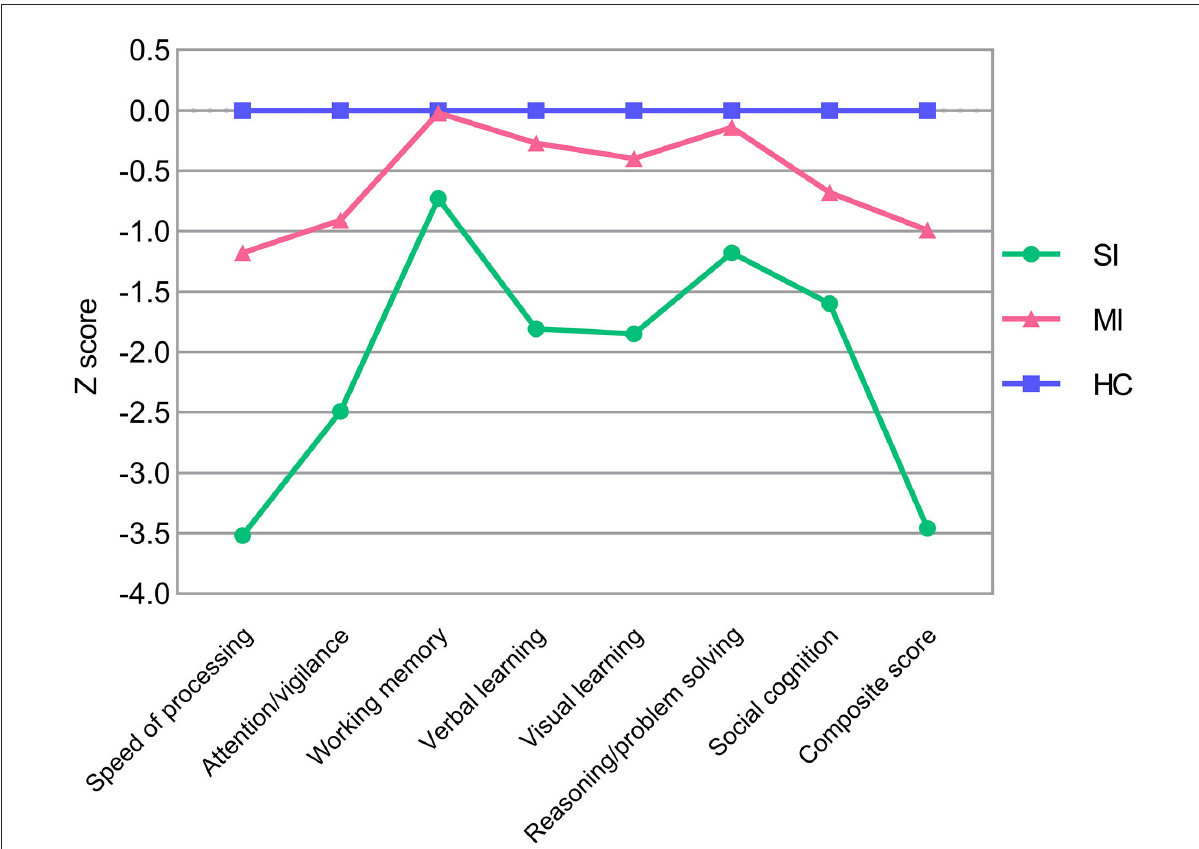
FIGURE1 MCCB cognitive scores in ECS cognitive subtypes (SI and MI) and HCs. Z scores of ECS cognitive subtypes are standardized against means and SDs of HC (mean = 0, SD = 1). Abbreviations: ECS, early course schizophrenia; SI, severely impaired subtype; MI, moderately impaired subtype; HC, healthy control; MCCB, MATRICS Consensus Cognitive Battery; SD, standard deviation.